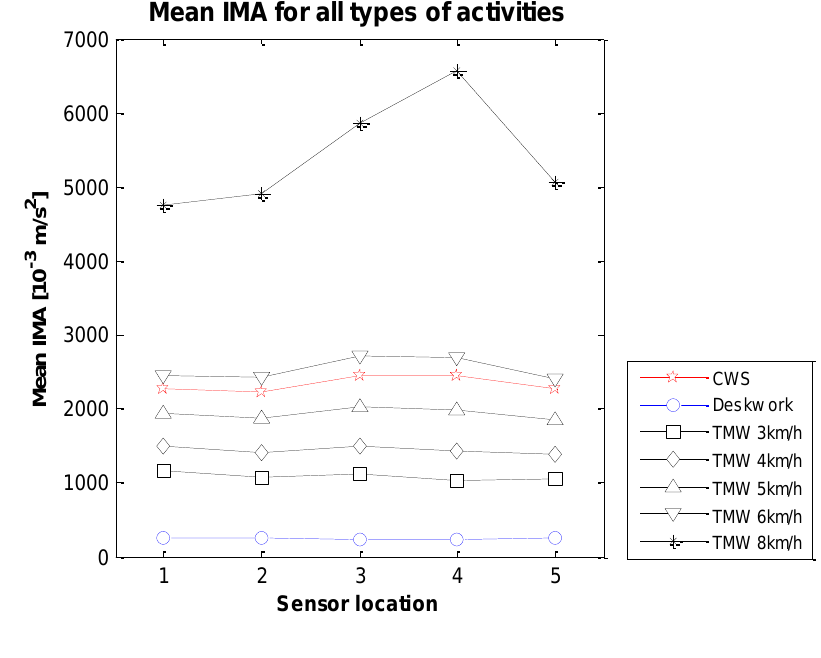
Figure 5. Mean IMA values for sensor locations 1–5, showing different lines for each type of activity (n = 10). TMW = treadmill walking; CWS = comfortable walking speed.